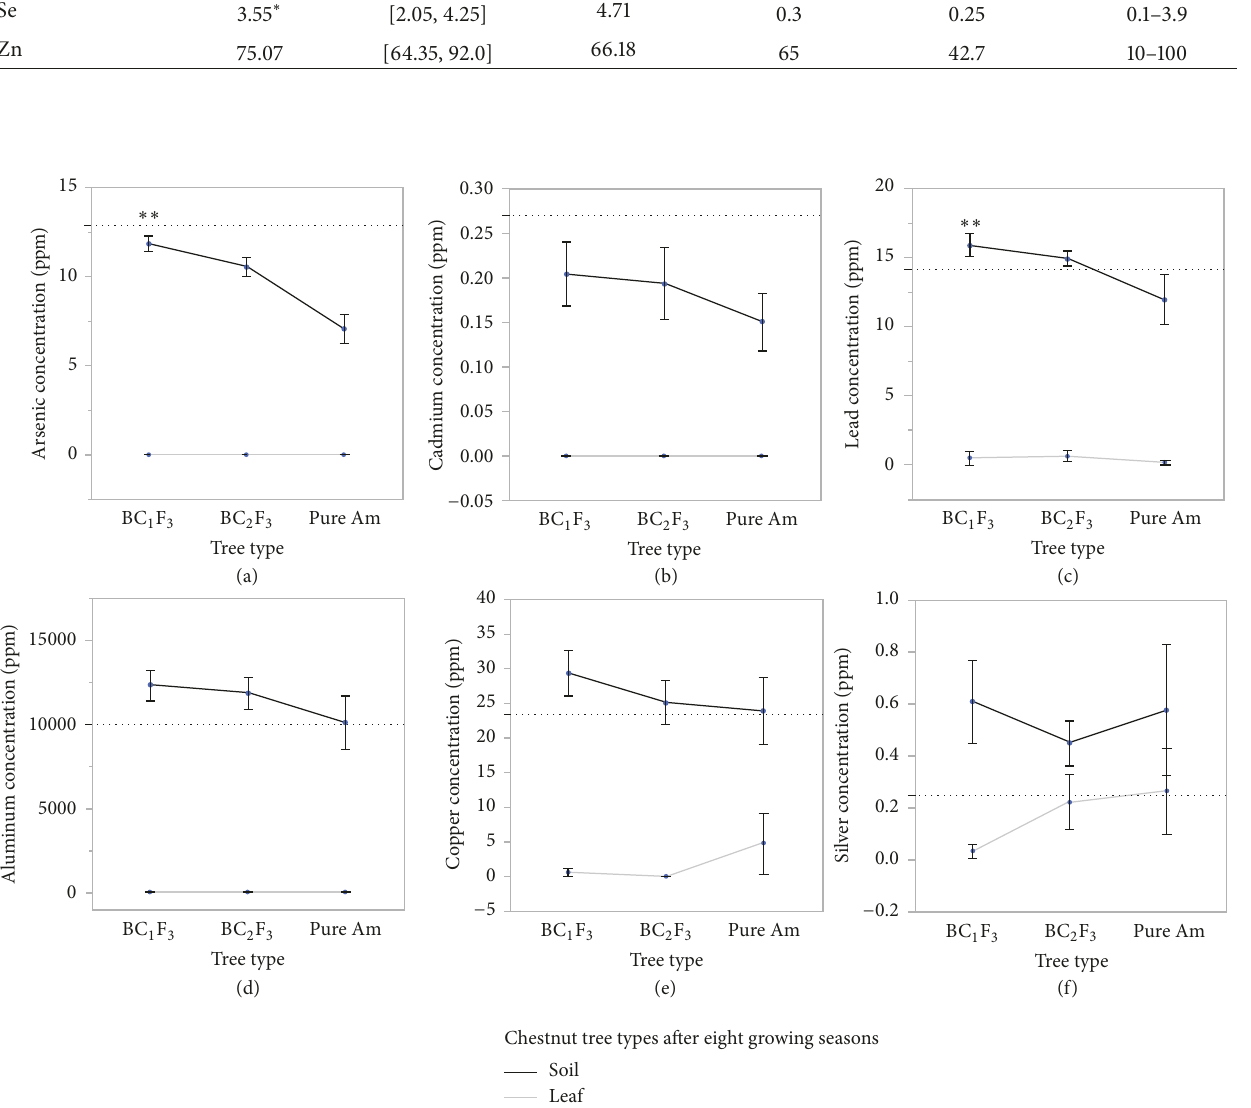
Figure 2: Mean soil (black lines) and leaf tissue (gray lines) concentrations of the six elements (As, Cd, Pb, Al, Cu, and Ag) that differed in concentration from soil to tissue by chestnut tree types (pure American, BC 1 F 3 , and BC 2 F 3 ) in Dresden, OH, USA ( 𝑛 = 29 ). Soils collected from the reference plots without tree plantings are illustrated as dotted lines on the graph. Asterisks ( ∗∗ ) indicate differences at